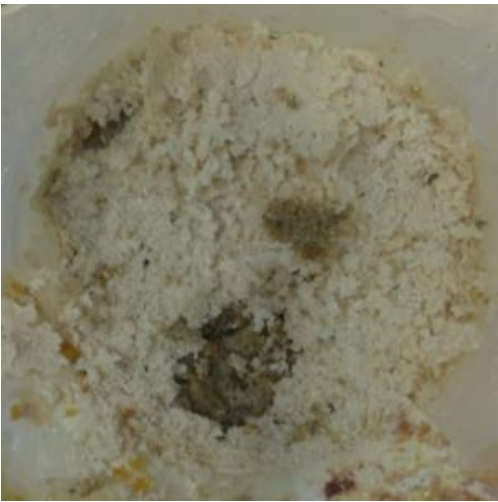
Figure 9. Complete degradation of the NBR-GF coating exposed to 30% CH 2 O 2 for 120 days.